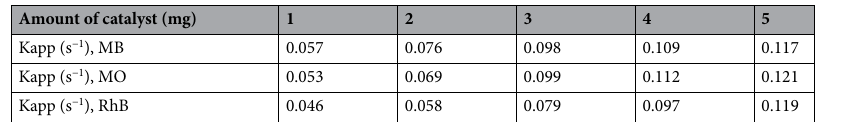
Table 2. The kapp of reduction reaction of MB, MO, and RhB with the amount of KIT-5-biguanidine-Au (0) nanocomposite.